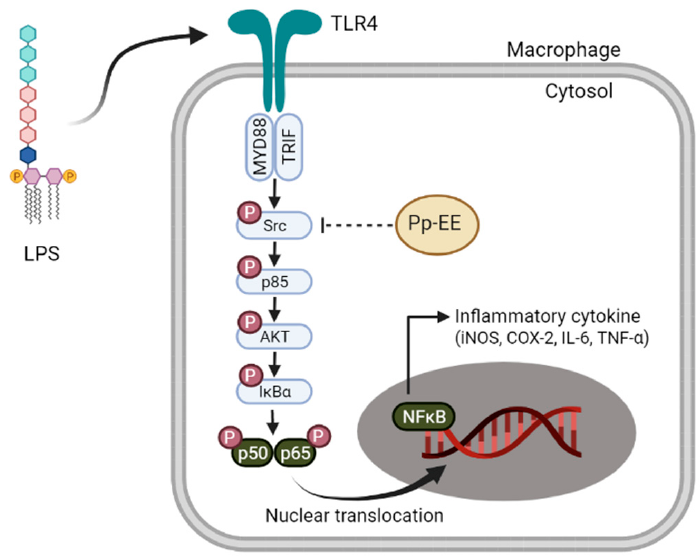
Figure 5. Schemes for mechanisms in which Pp-EE has anti-inflammatory efficacy targeting Src.